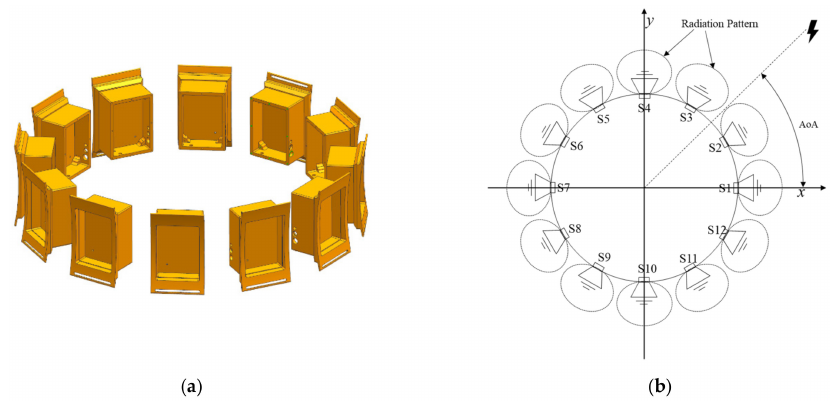
Figure 6. UHF antenna power pattern: ( a ) Side view; ( b ) Top